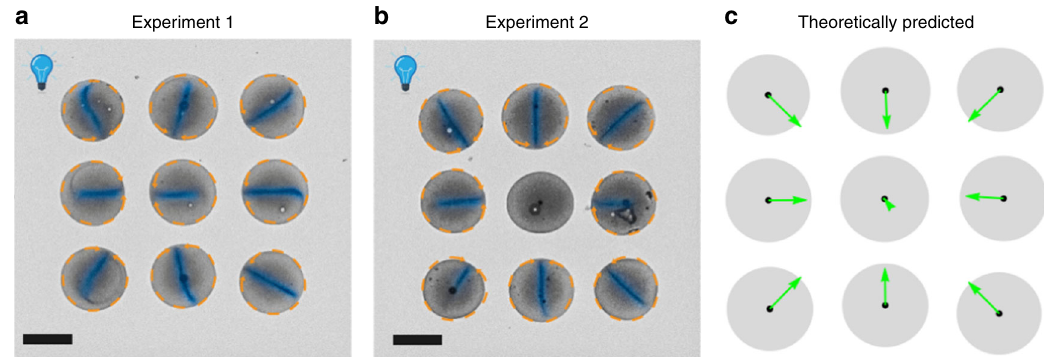
Fig. 5 Alignment of the fl ow directors for arrays with high symmetry. The emergent alignment of the directors of drops arranged in square arrays of size 3 × 3 for two independent experiments (left and middle panel; for visual clarity, the region around the director is shaded in blue in accordance with the observed gray scale density). The right panel shows the theoretically predicted chemical gradients, i.e., the director d before normalization (see Supplementary Note 3) with the activity strength Q i taken to be proportional to the area of the base of the i -th drop. The differences in the emergent orientations of the directors between the two repeats of the experiment are clearly noticeable in the central part of the ensemble. The scale bars correspond to 150 μ